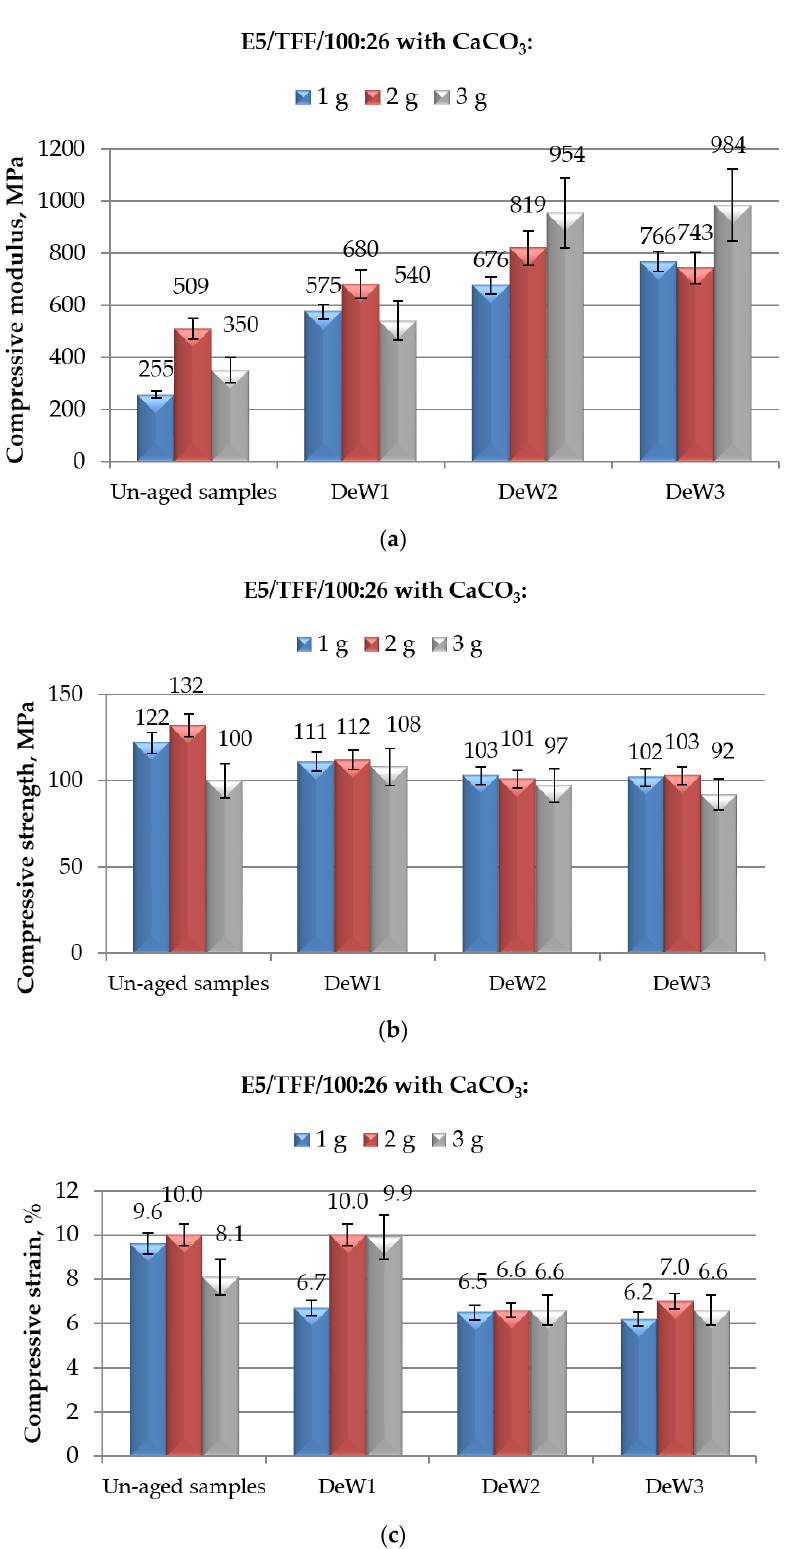
Figure 4. Results of mechanical (in compression mode) tests performed on E5/TFF/100:26 epoxy compounds filled with different amounts of CaCO 3 and aged for different time spans (from 1 to 10 months) in demineralised water: ( a ) compressive modulus; ( b ) compressive maximum strength; and ( c ) compressive strain at break.